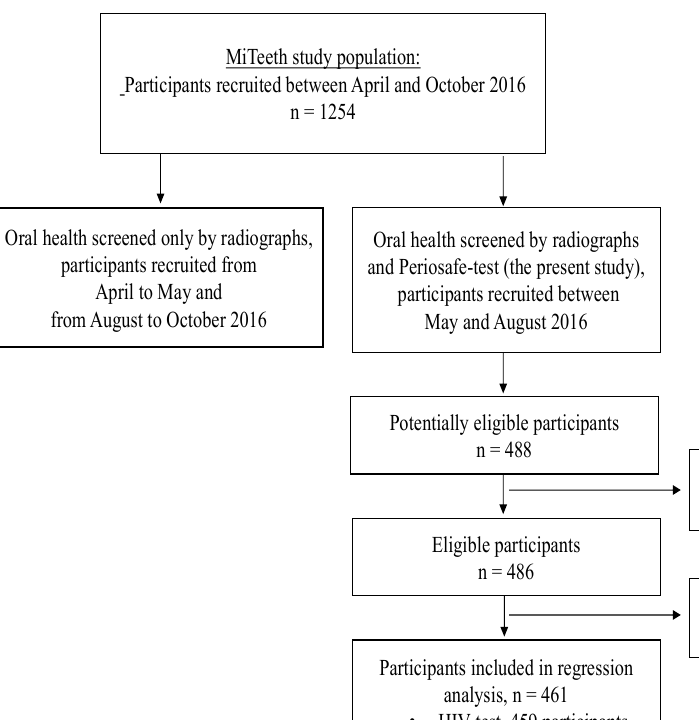
Figure 2. Schematic representation of participant flow.